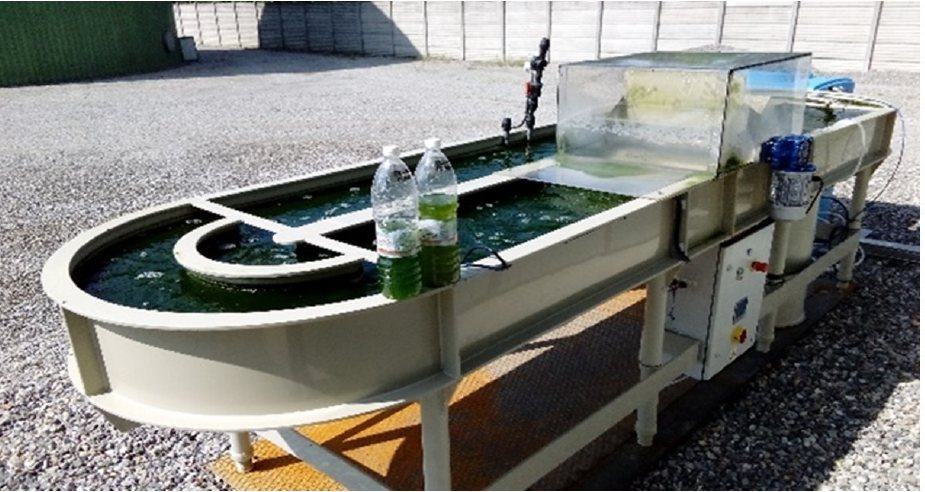
Figure 1. Pilot-scale HRABP located in a piggery farm in the north of Italy (Casaletto di Sopra, Cremona,